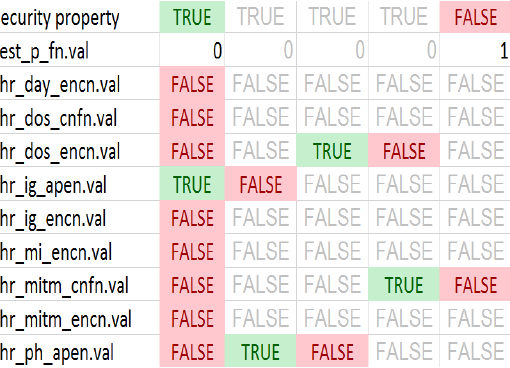
Figure 3 . Delivered counter example.